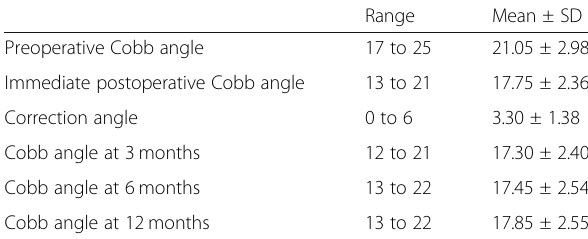
Table 4 Cobb angle before and after surgery in the studied